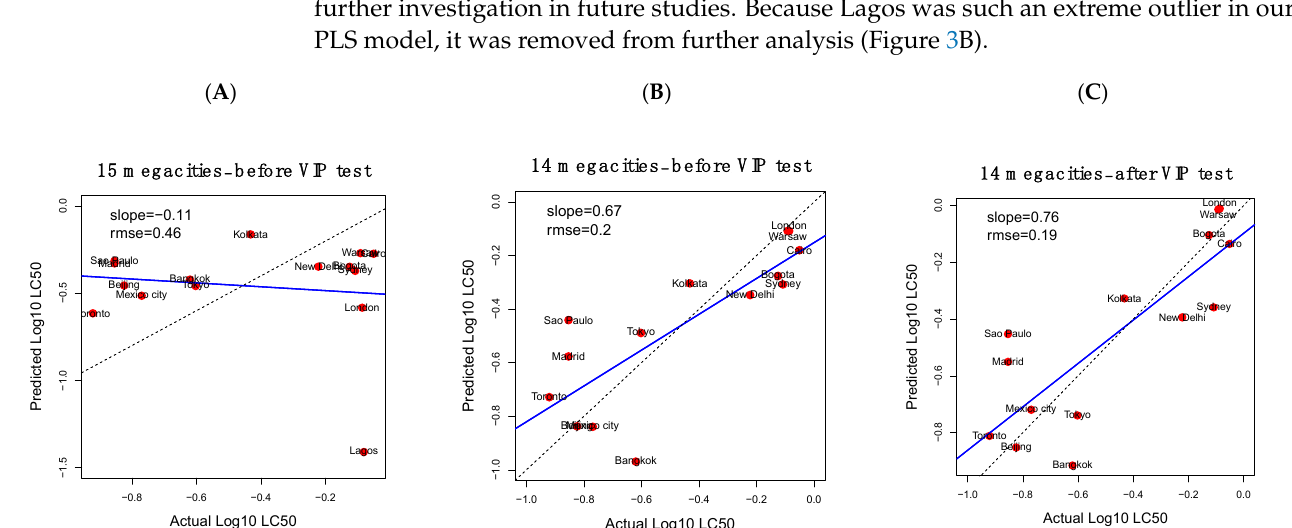
Figure 3. Partial least square (PLS) regression modeling for estimating cytotoxicity from organic flame retardant concentra- tions. ( A ) Preliminary modeling showed that Lagos was an outlier, so it was removed in the following analysis; ( B ) the preliminary model after Lagos was removed; and ( C ) the final PLS model after filtering for predictor variables with VIP scores > 1. The blue line indicates the regression between estimated and actual LC50 values. The dashed line represents a perfect 1-to-1 prediction. VIP = variable importance in projection. Table 1. LC50 values for 19 global megacities. Concentration data were log-transformed and percent viability data were fit to a nonlinear regression curve to determine the LC50. ND, not determined; -, no change. Simple regression analysis was performed between all endpoints (detailed in Figure S1).